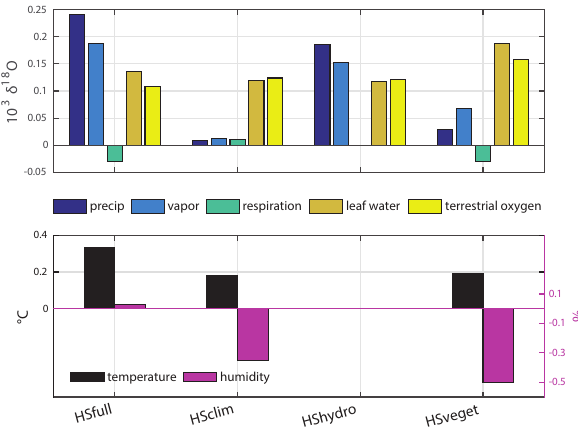
Figure 11. Summary of sensitivity study experiments. HSfull uses the same settings as HS_exp, while HSclim, HShydro and HSveget experiments are identical to LGM_ctrl, except for meteoric wa- ter isotopic composition, climatic conditions, or vegetation pro- duction and distribution, respectively, originating from HS_exp. For each of the experiments, an annual-mean anomaly (experiment – LGM_ctrl) of oxygen-production-weighted temperature, relative humidity, δ 18 O p , water vapor δ 18 O, δ 18 O lw , 18 (cid:15) resp and δ 18 O terr is